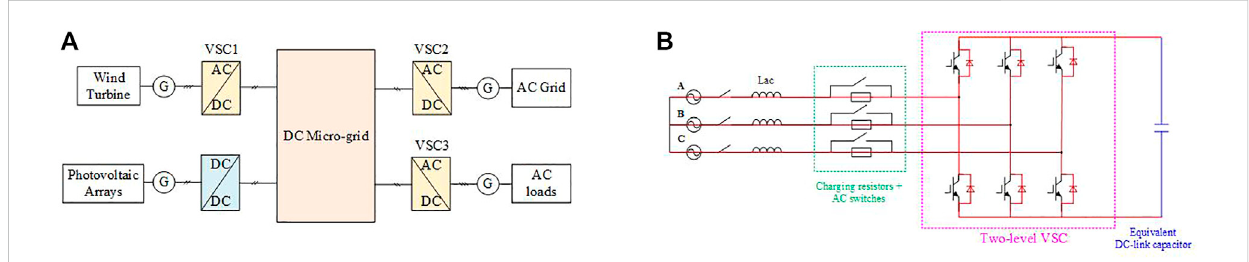
FIGURE 1 Typical schematic of DC micro-grid and the topology of conventional two-level VSC during start-up process. (A) Typical schematic of DC micro- grid; (B) topology of conventional two-level